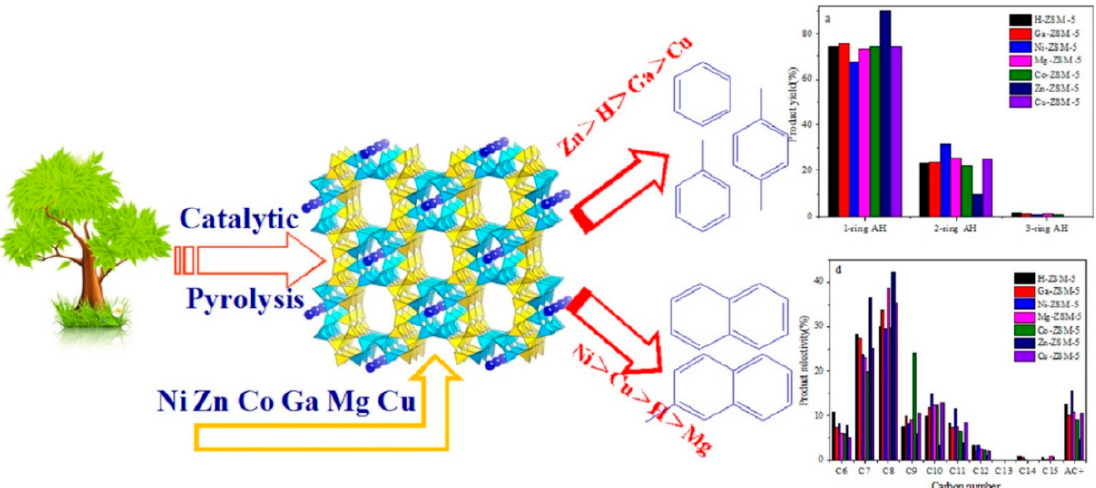
Figure 2. Effects of nickel salts on the characteristics of typical products paralyzed from alkali lignin at 600°C. APs: Alkylphenols; UACs: Unsaturated aromatic compounds; SACs: Saturated aromatic compounds [11] .